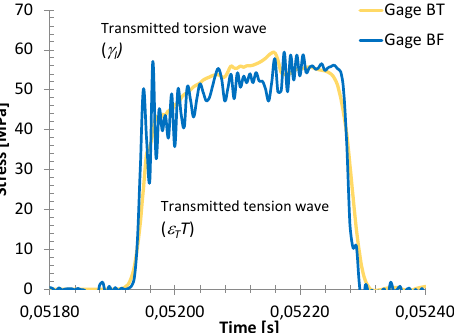
Fig. 7. Waves recorded by the virtual strain gauges in position B T and B